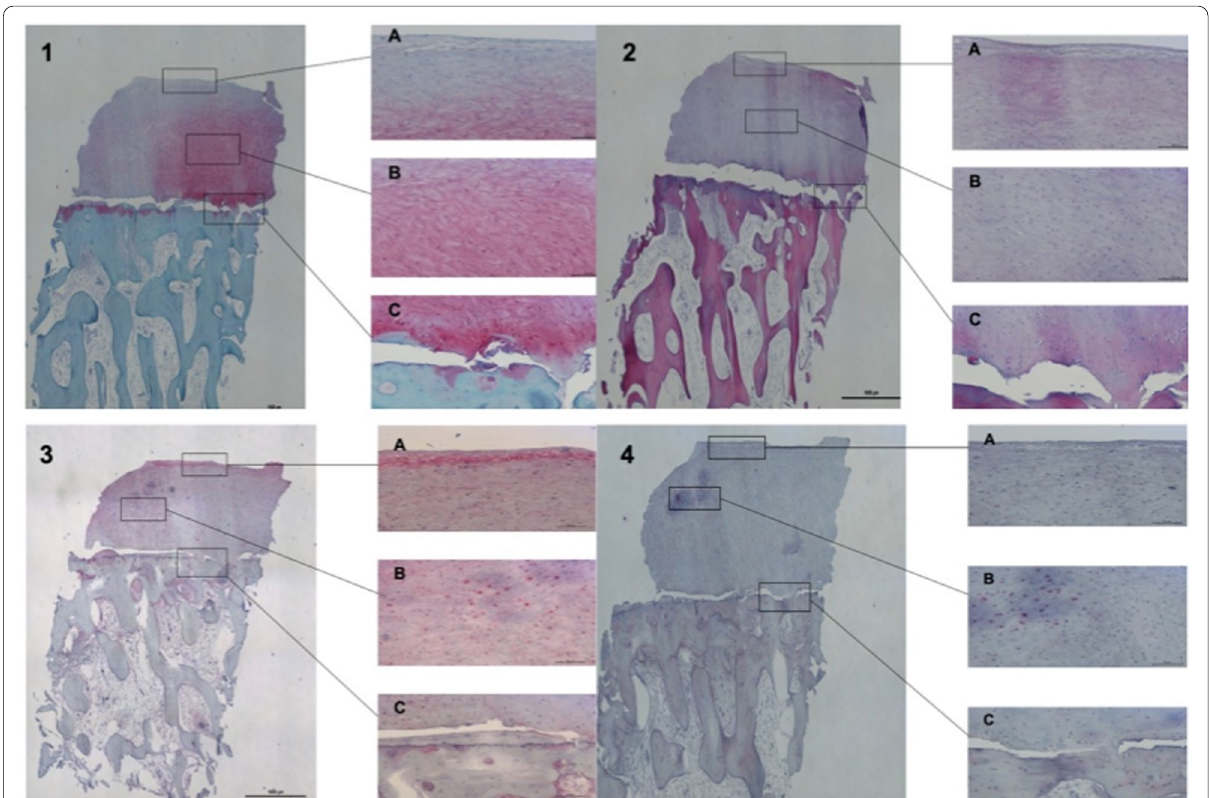
Fig. 13 Safranin-O/Fast Green shows the presence of matrix proteoglycans in the middle and deep zones. Tidemark is also adjacent to subchondral bone ( 1 ). Haematoxylin–Eosin staining, where an organized cartilage tissue with a regular and smooth surface is seen ( 2 ). Immunohistochemistry with Collagen II is positive in the middle and deep zones, both in the extracellular and cellular ( 3 ). Collagen I is negative, except for some areas ( 4 ). All cuts demonstrate delamination the above tidemark. 475 317 mm. 2 (144 144 × ×